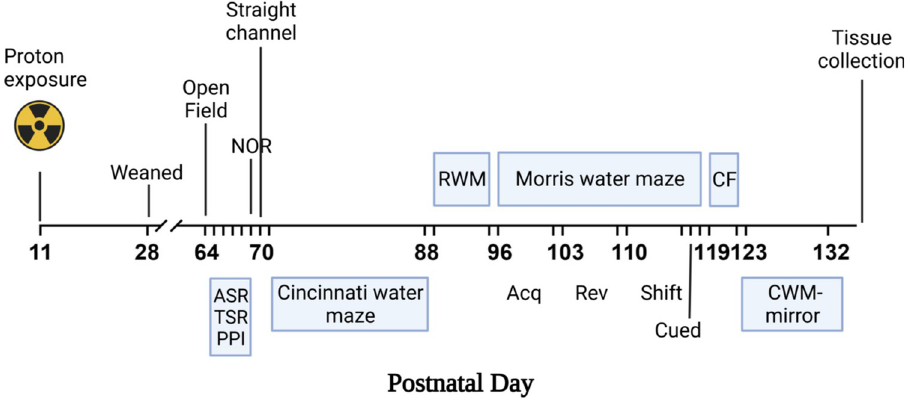
Fig 1. Experimental timeline. The experimental timeline in postnatal days. Abbreviations: ASR- acoustic startle response; TSR- tactile startle response; PPI- prepulse inhibition; NOR- novel object recognition; RWM- radial water maze; CF- conditioned freezing; CWM- Cincinnati water maze. Created with